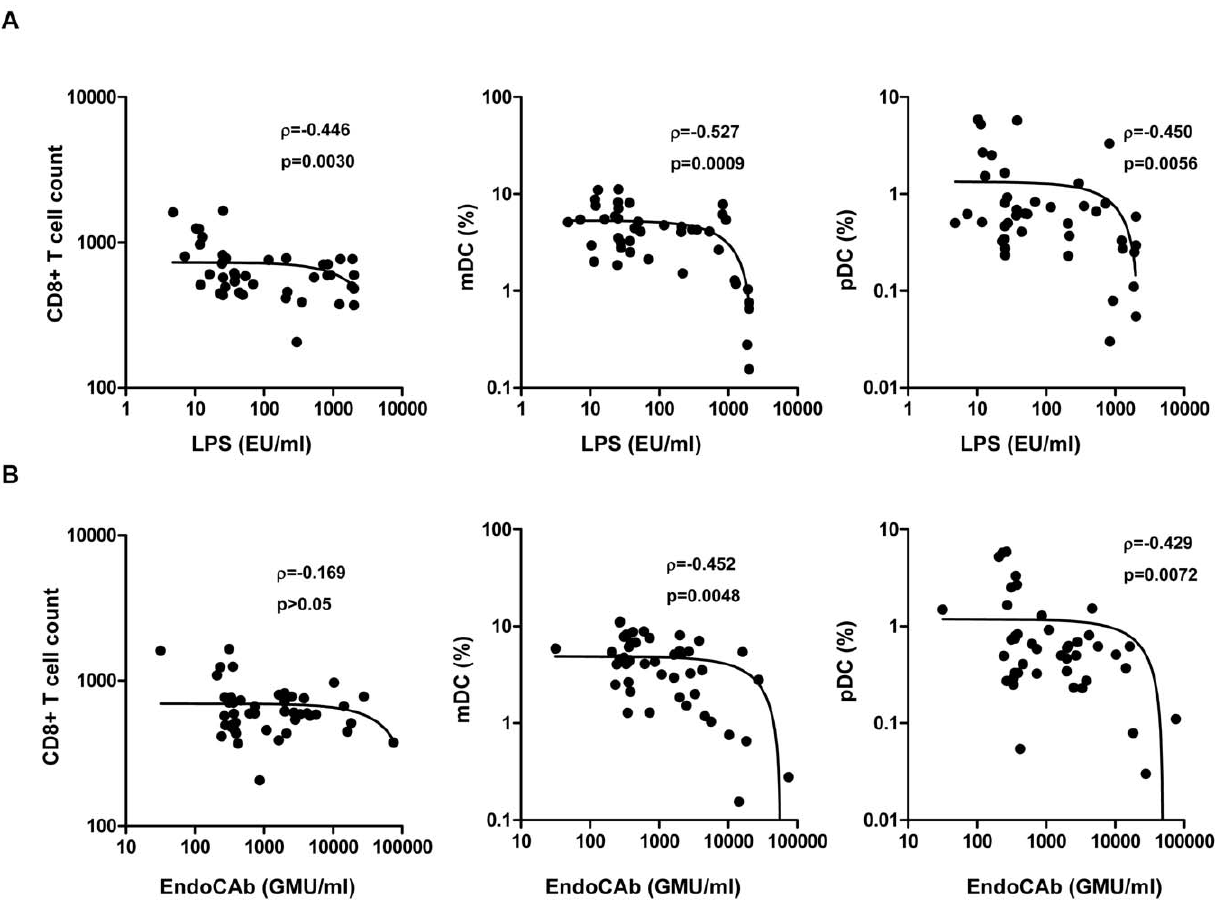
Figure 4. Correlation between microbial translocation markers and CD8 + T cells and DC subsets in hookworm-infected individuals. A , Plasma levels of lipopolysaccharide (LPS) were correlated with the absolute counts of CD8 + T cells and frequencies of myeloid (mDC) and plasmacytoid DC (pDC) in hookworm-infected individuals (n=46). B , Plasma levels of endotoxin core antibody IgG (EndoCAb) were correlated with the absolute counts of CD8 + T cells and frequencies of mDC and pDC in hookworm-infected individuals (n=46). P and r values were calculated using the Spearman rank correlation test at 95% confidence intervals.